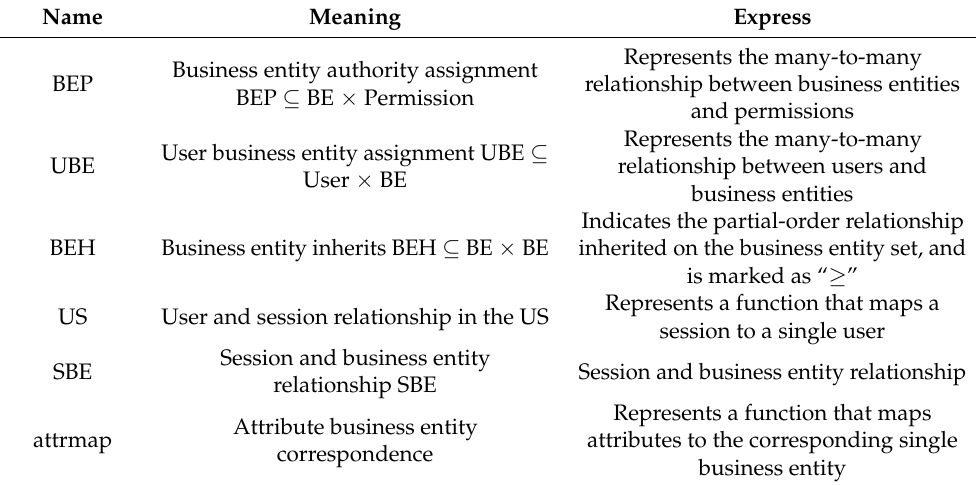
Table 1. Description of access-control model relationship, based on business